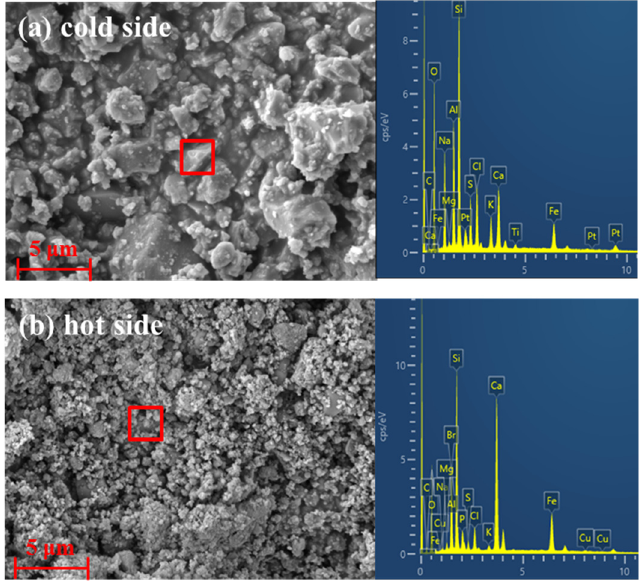
Figure 3. SEM micrographs and EDS analysis of the slagging samples collected from the exit flue of the secondary combustion chamber: ( a ) surface in contact with the tube wall; and ( b ) surface in contact with the high-temperature exhaust gas.